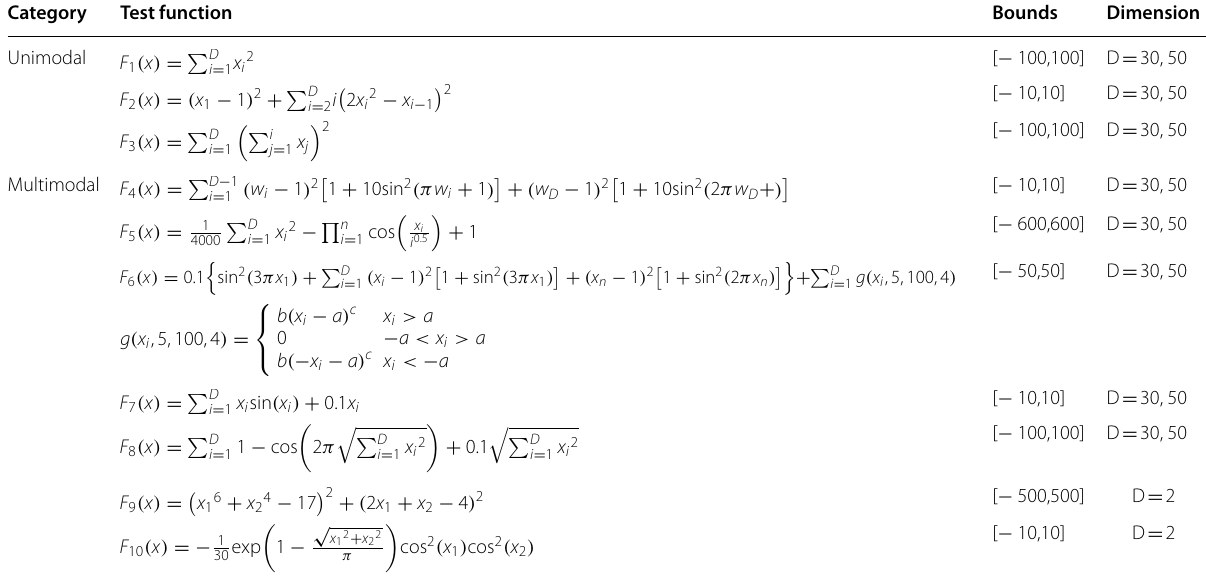
Table 2 Details of selected benchmark functions Category Test function Bounds